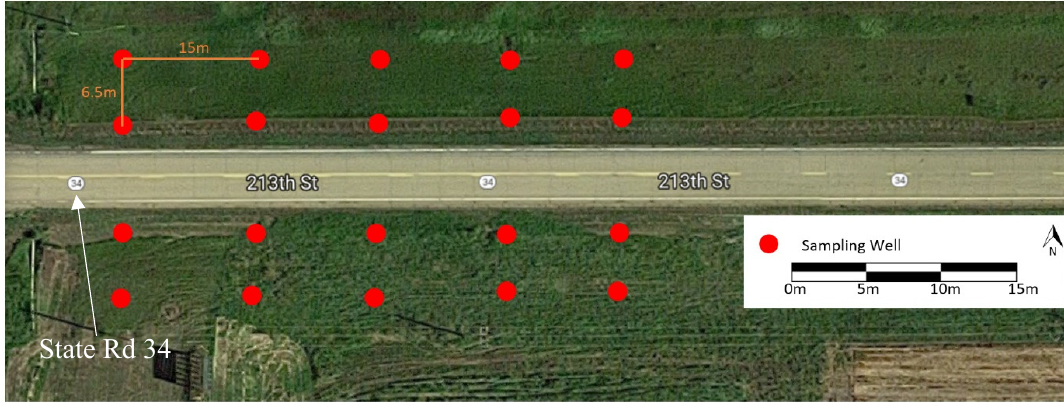
Figure 3. Schematic diagram of leachate sampling locations in roadside ditches during this study in South Dakota.